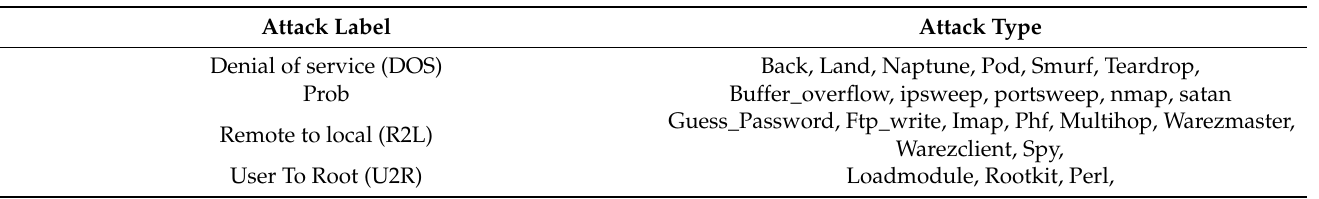
Table 3. Train set attack classification. Data from